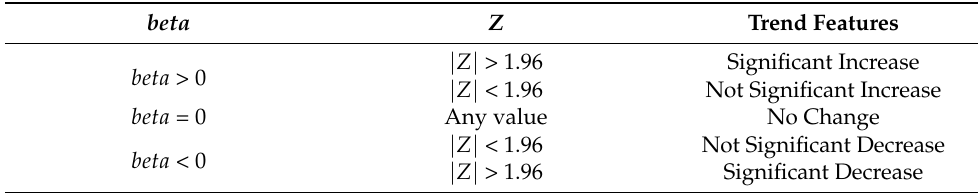
Table 2. Sen+MK trend analysis